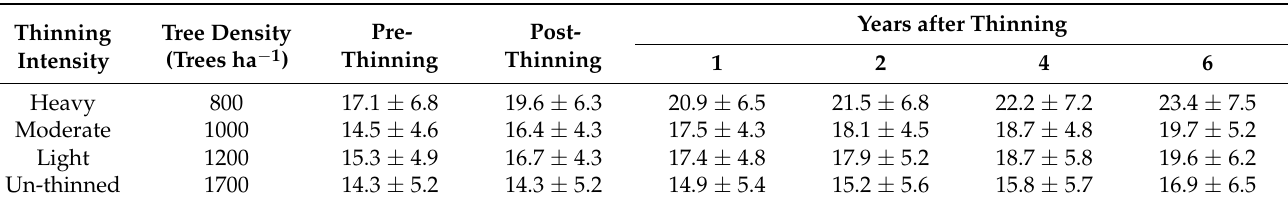
Figure 1. Map of the Guanmiao Farm, Guanmiao, Taiwan showing the afforested area of Honduras mahogany and the climograph. Table 1. Average diameter at breast height (DBH; cm) of four plots of Honduras mahogany in the Guanmiao Farm, Guanmiao, Taiwan before and after